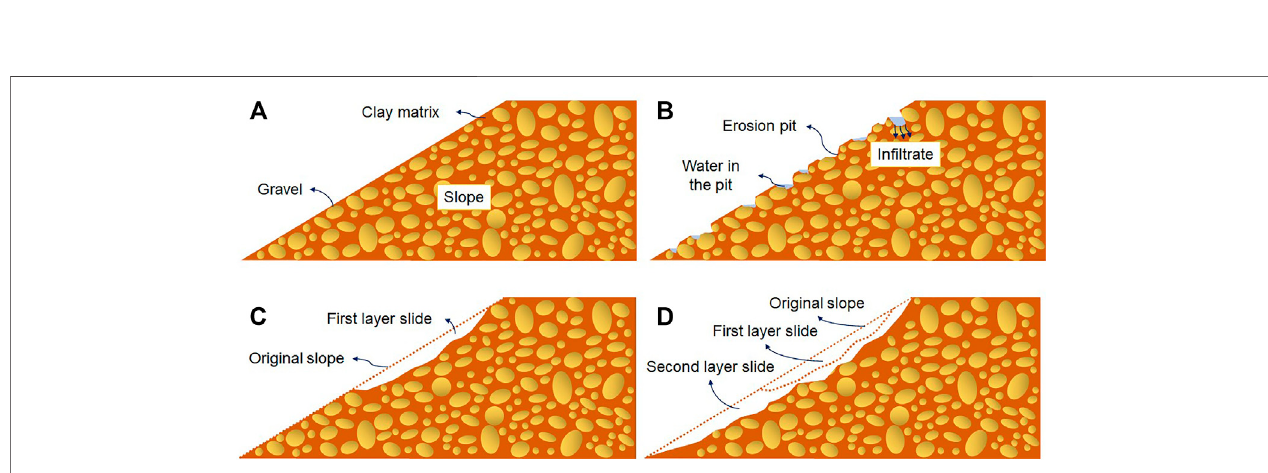
FIGURE 11 | Simpli fi ed diagram of slope erosion failure evolution law (gravel content 50%). (A) Initial slope (B) erosion pits (C) slope local damage (D) slope extensive damage.